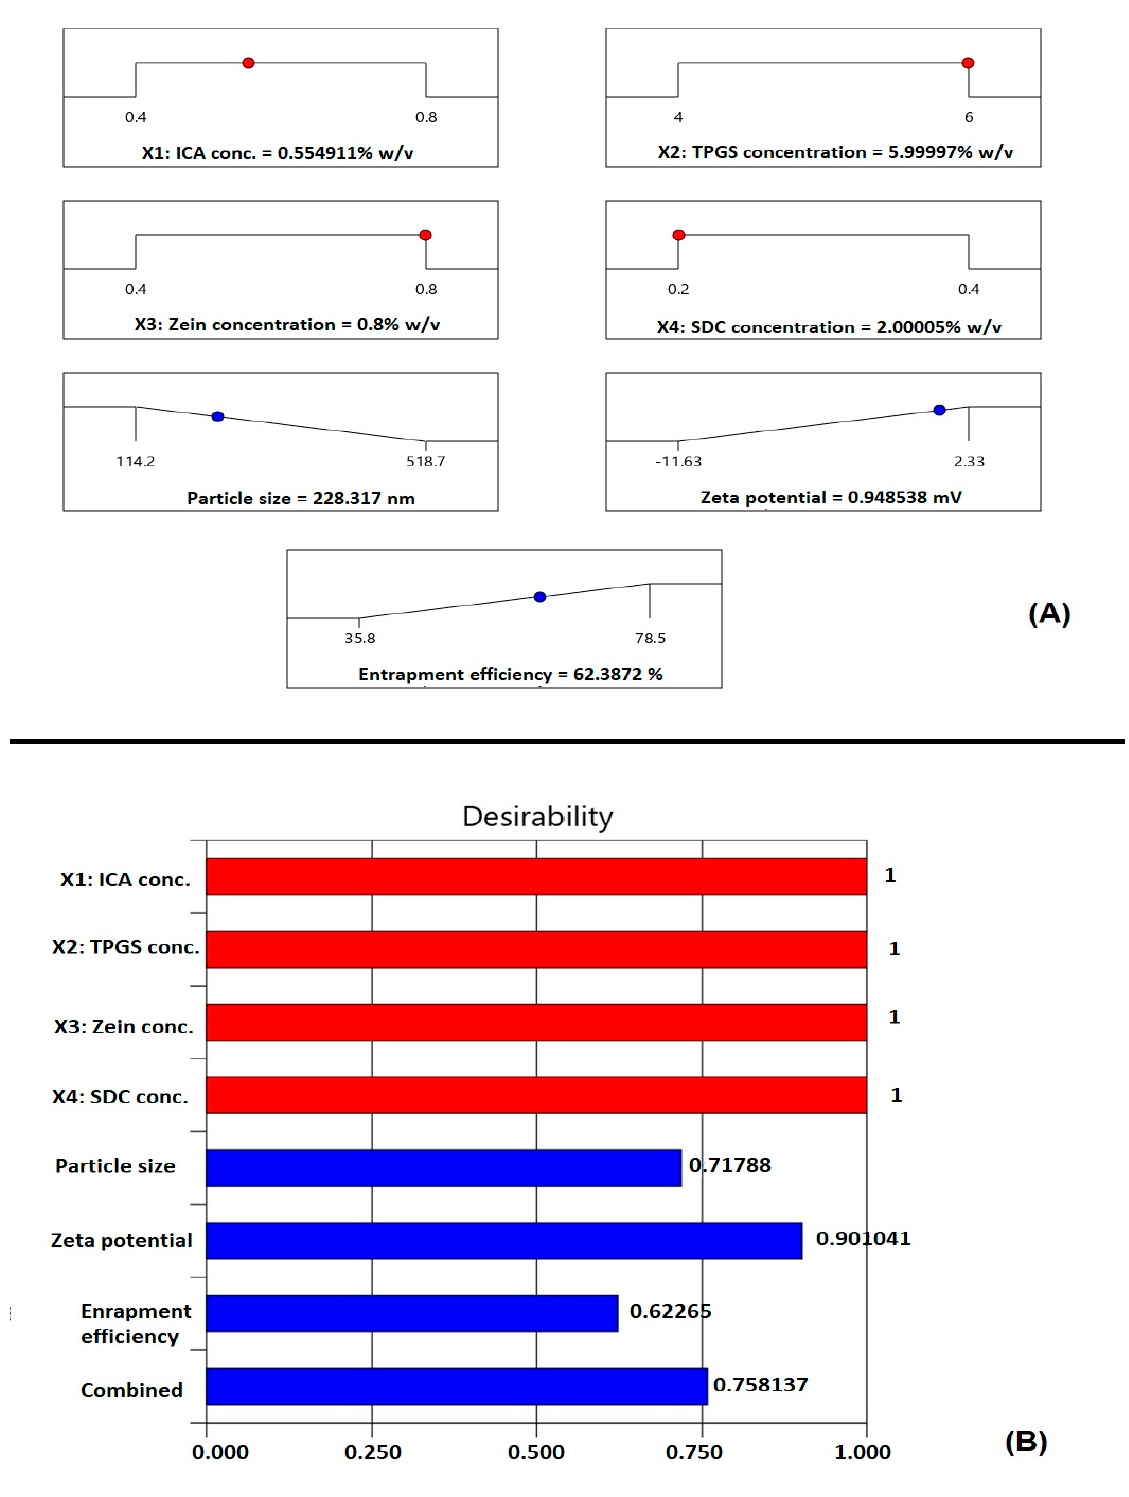
Figure 5. ( A ) Ramp graphs representing the optimized factor levels and the predicted responses for the optimized ICA–tocozeinolate nanospheres. ( B ) Desirability values for the predicted responses and overall desirability of the optimized ICA–tocozeinolate